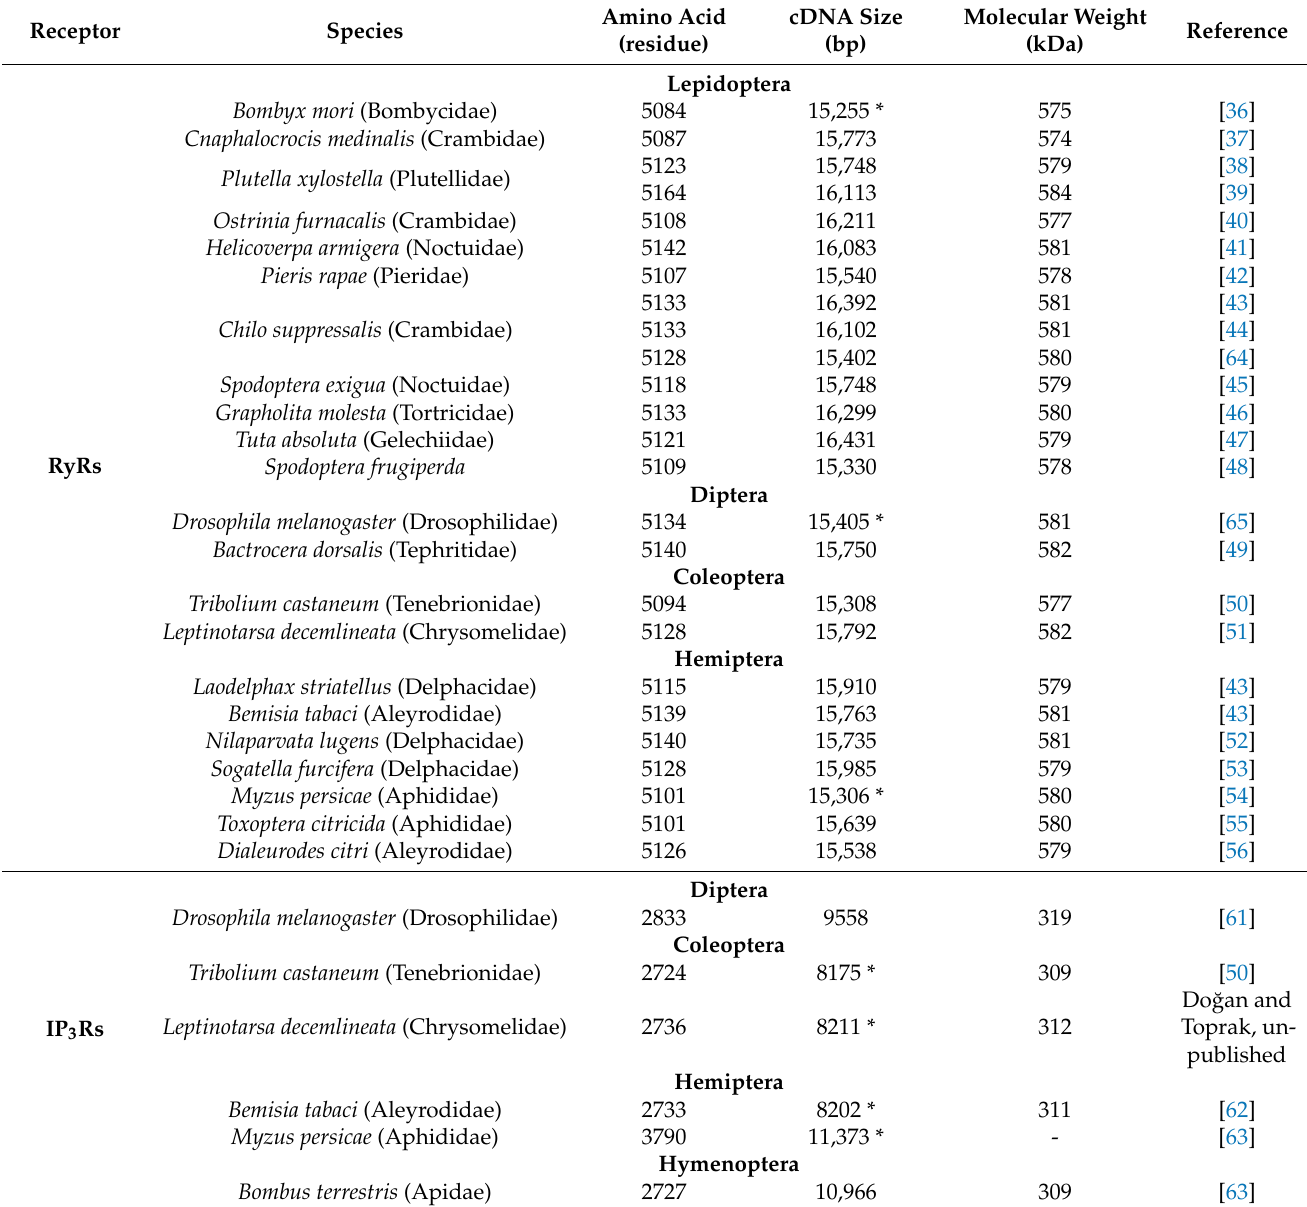
Table 1. Insect ryanodine receptors (RyRs) and inositol triphosphate receptors (IP 3 Rs) identified to date. Receptor Species